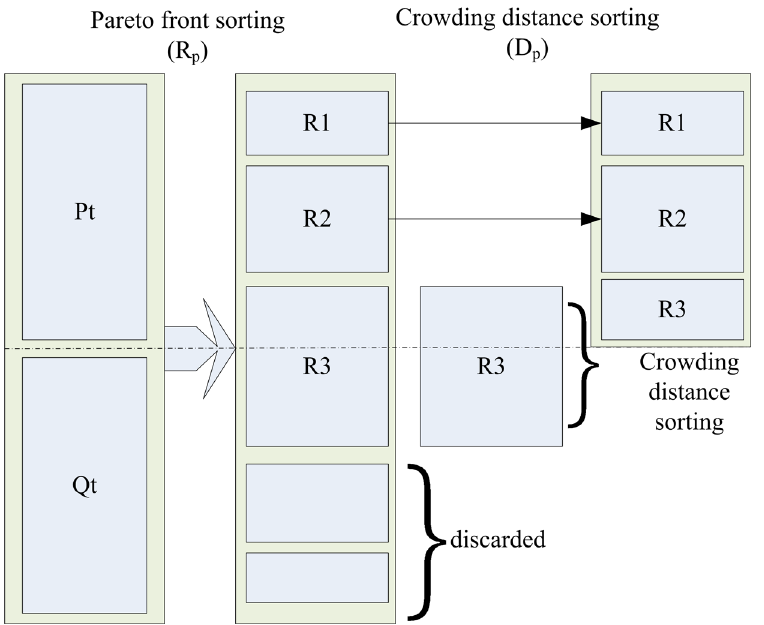
Fig 5. Selection operator of